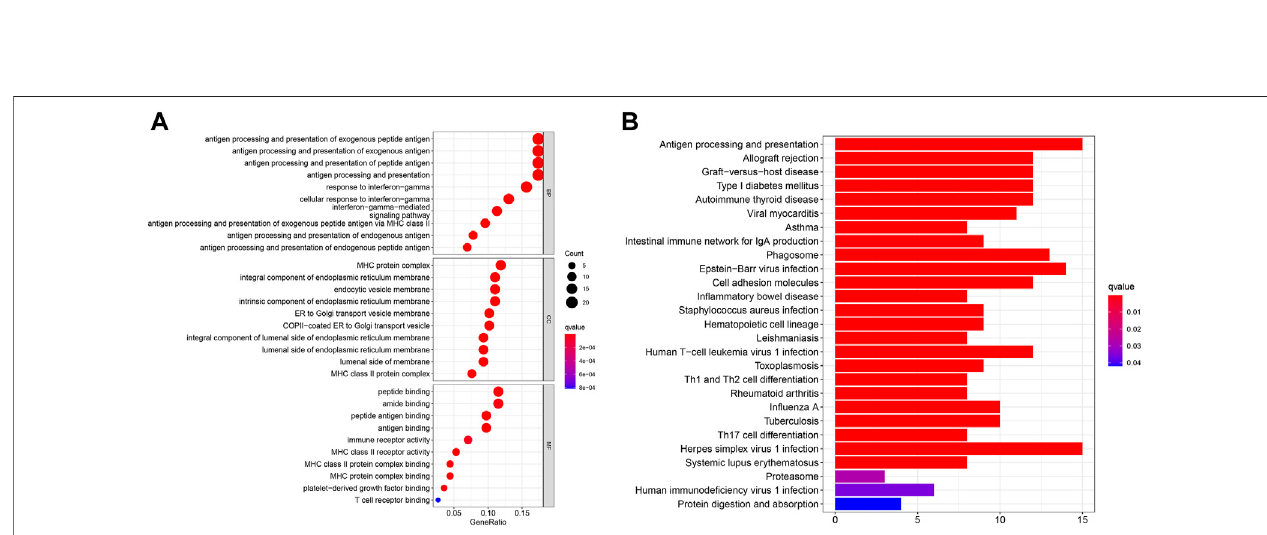
FIGURE7 |(A) Bubble graphshows the analysis ofGO enrichment forDEGs betweentwo riskgroups. (B) Barplot graph shows theanalysisofKEGG enrichment for DEGs between two risk groups.